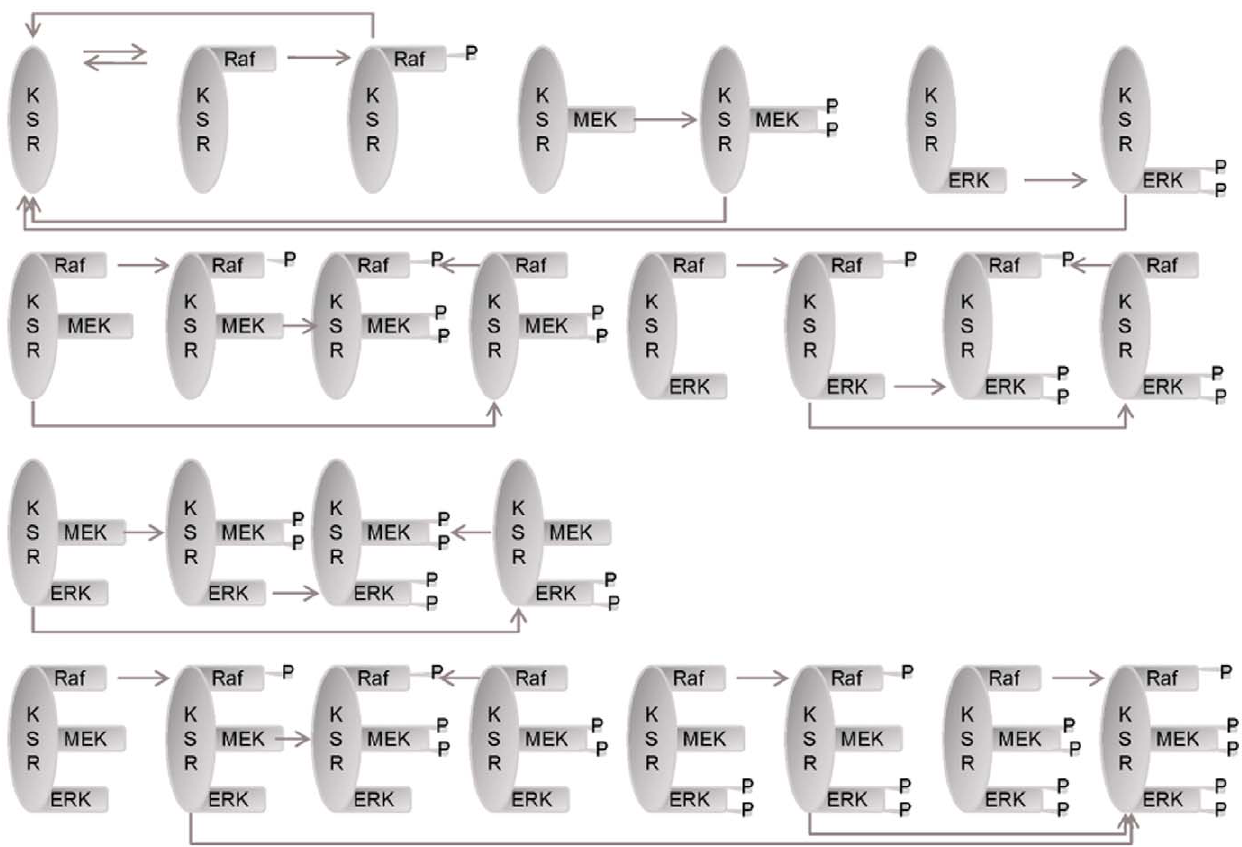
Figure 2. A detailed biochemical model of scaffolding action of KSR. Please refer to ‘‘Methods’’ for the considerations and assumptions used and Supplementary Table S1 for detailed descriptions of the kinetics parameters. ‘‘P’’ denotes protein phosphorylation.